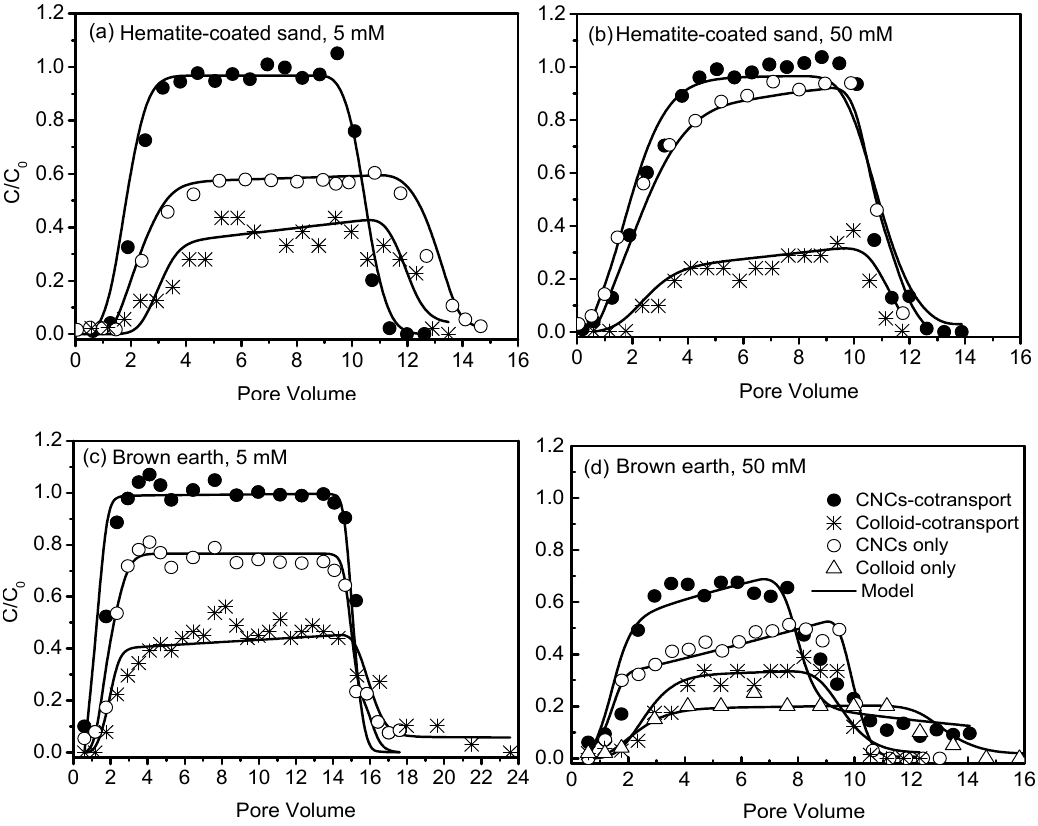
Figure 6. Effect of soil colloids (50 mg L − 1 ) on the transport of CNCs (200 mg L − 1 ) through hematite-coated sand at 5 mM ( a ) and 50 mM ( b ) and brown earth at 5 mM ( c ) and 50 mM ( d ).